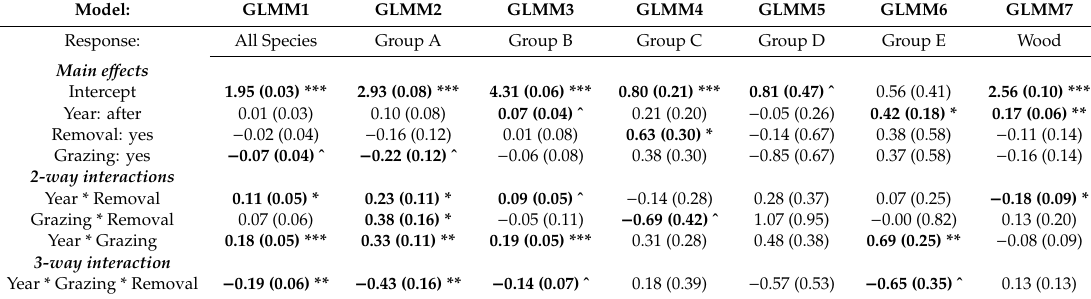
Table 1. Generalised linear mixed models with negative-binomial error structure analysing coverage of plant groups in reaction to conservation treatments (mechanical removal and grazing) and over